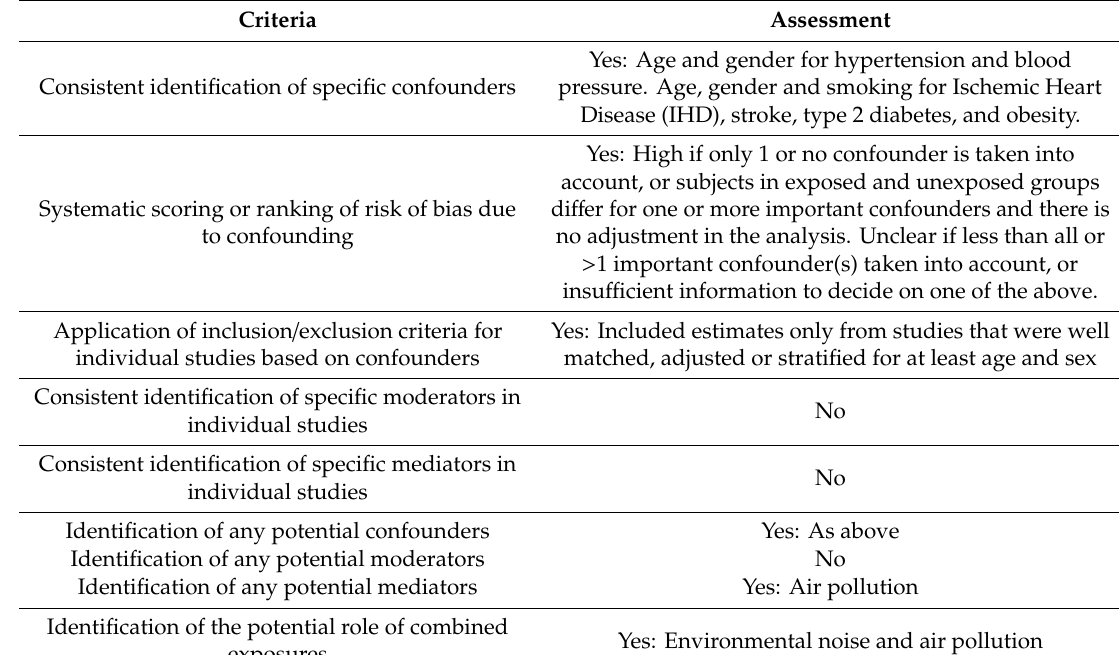
Table 1. Assessment for cardiovascular and metabolic e ff